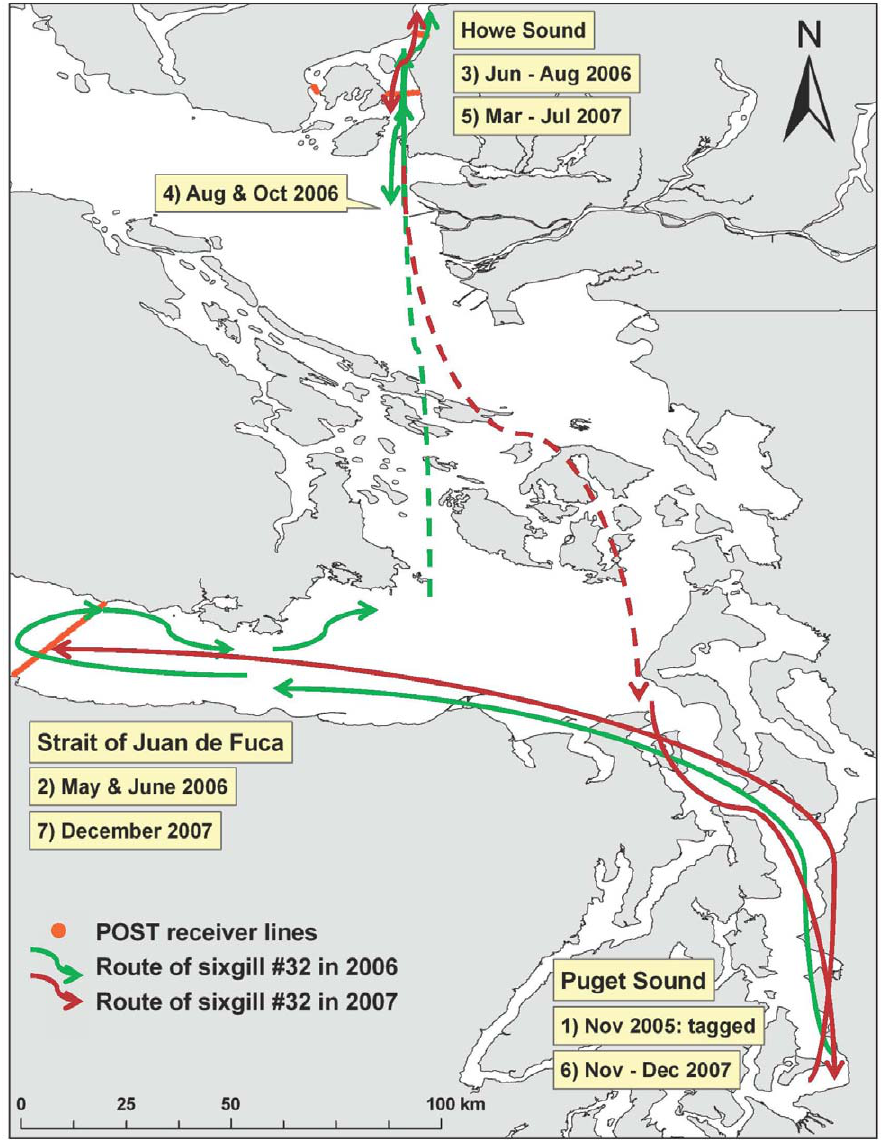
Figure 7. Movement of a female sixgill shark ( # 32) from 2005 to 2007.